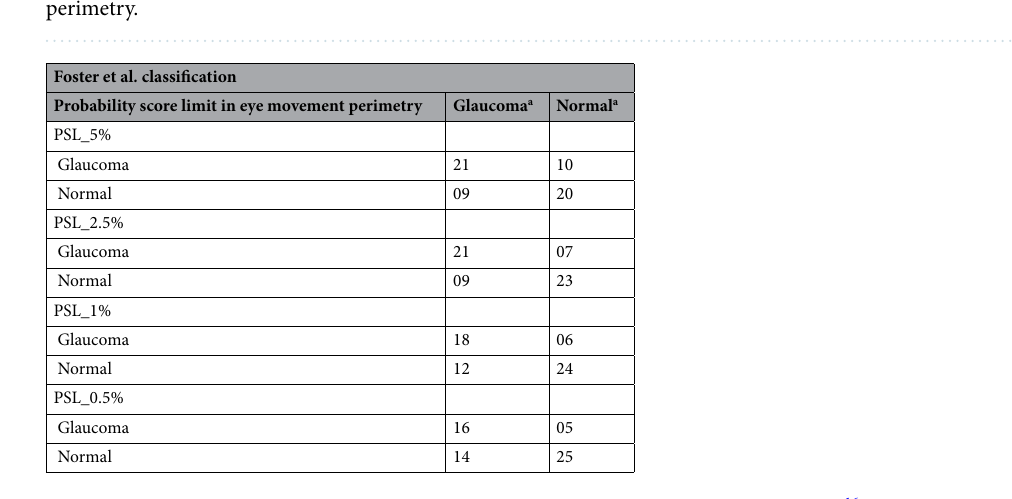
Table 5. Contingency table for PSL from eye movement perimetry using the Foster et al . 16 classification for glaucoma as reference. PSL, probability score limits. a All values represent number of subjects.